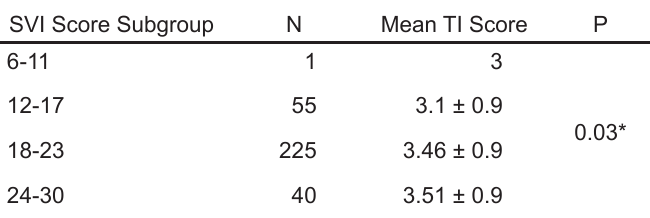
Table 3. Relationship between the Standardized Video Interview score and traditional interview score by